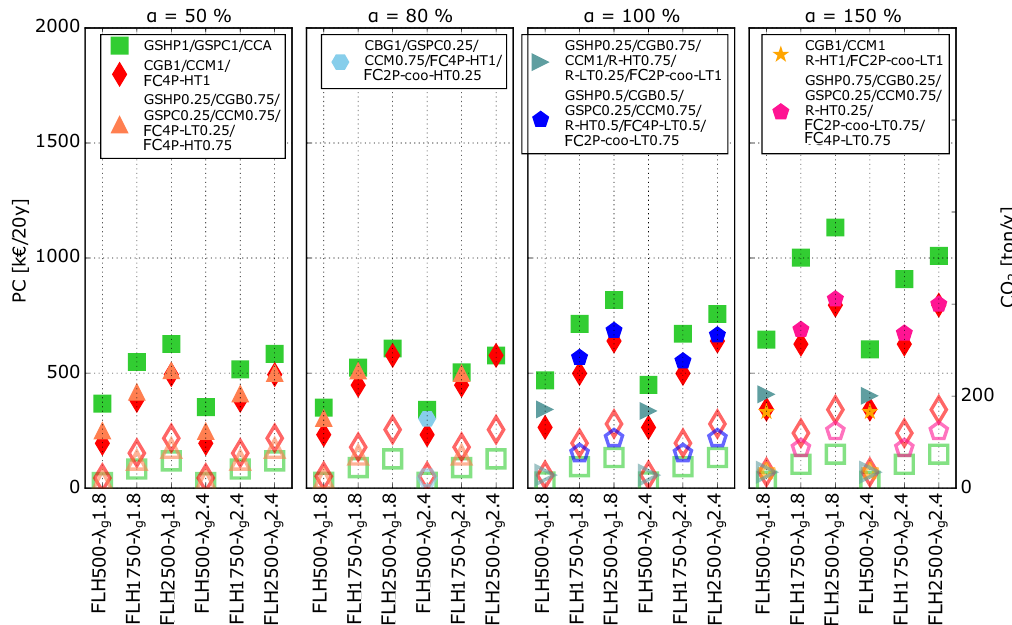
Figure 7. Present Cost (PC , filled markers) and CO 2 emissions (unfilled markers) of HVAC scenarios ( Geo-Sce ) containing maximum two heat and two cold production systems, each coupled to its own emission system for the different parameter values of Table 4 but P h,max = 150 kW, P spe = 27 W/m 2 and the Load Duration Curve (LDC) are of triangular shape. Only the GEOTABS ( GEOTABS-M-Sce ), the most conventional ( Conv-M-Sce ), the cheapest ( M-Sce *) and the cheapest geothermal scenarios ( Geo-Sce *) are plotted. The legend specifies the components of the HVAC scenario and the fraction of installed power they